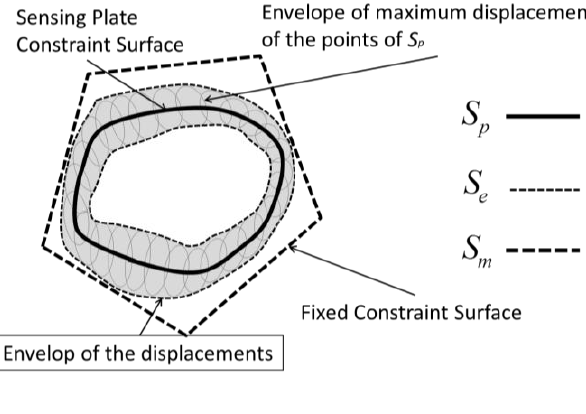
Figure 8. Scheme of the principle for the synthesis of candidate surfaces for overload